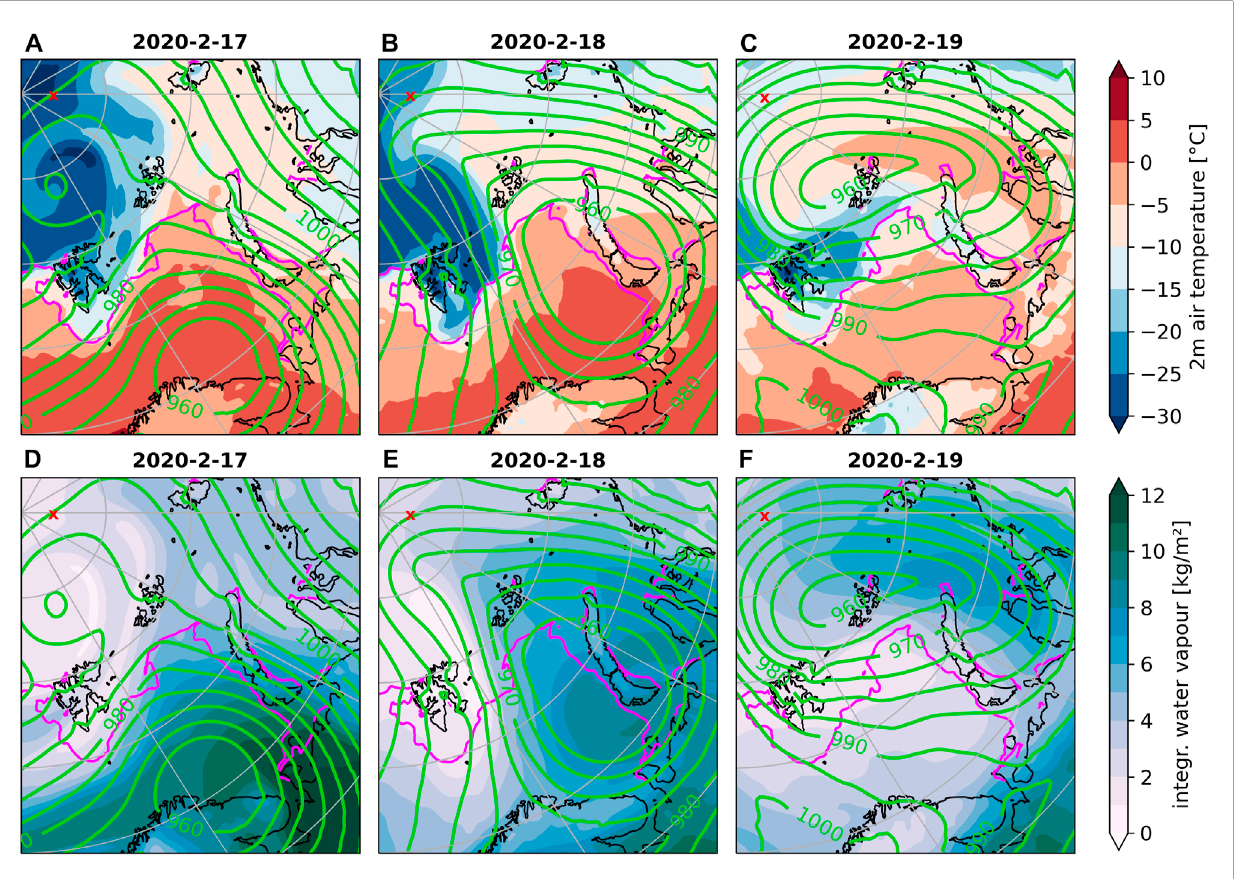
FIGURE 2 Daily means of 2-m air temperature (A–C) and integrated water vapour (IWV) (D–F) during cyclone 2 (17.2.2020—19.2.2020) based on the HIRHAM–NAOSIM simulation. Green contour lines represent daily mean sea level pressure (in steps of 5 hPa); pink lines indicate the position of the ice edge (15% SIC). The position of the RV Polarstern at the corresponding days is marked as red